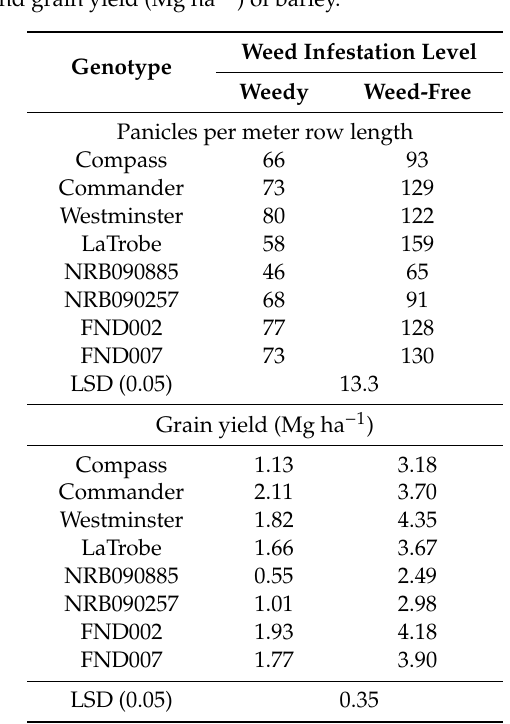
Figure 4. E ff ect of genotypes on the plant height (cm) of barley. Means followed by same letter are not significantly di ff erent at p = 0.05. Table 4. Interaction e ff ect of the weed infestation level and genotype on the panicle density (number per meter row length) and grain yield (Mg ha − 1 ) of